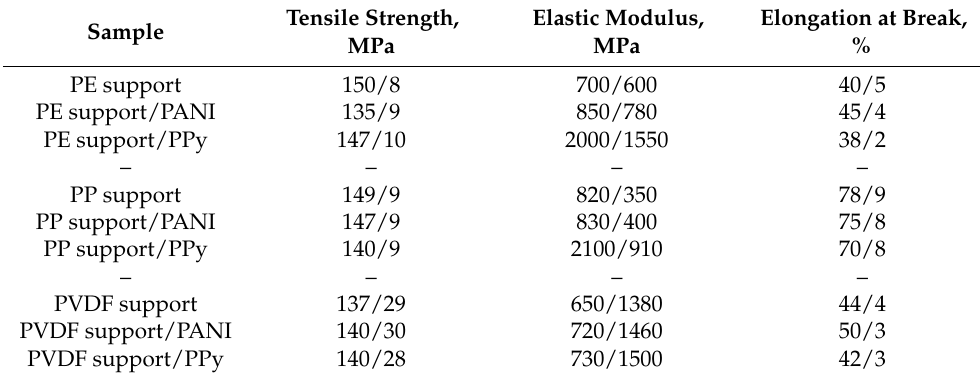
Table 5. Mechanical characteristics of the porous supports and the composites